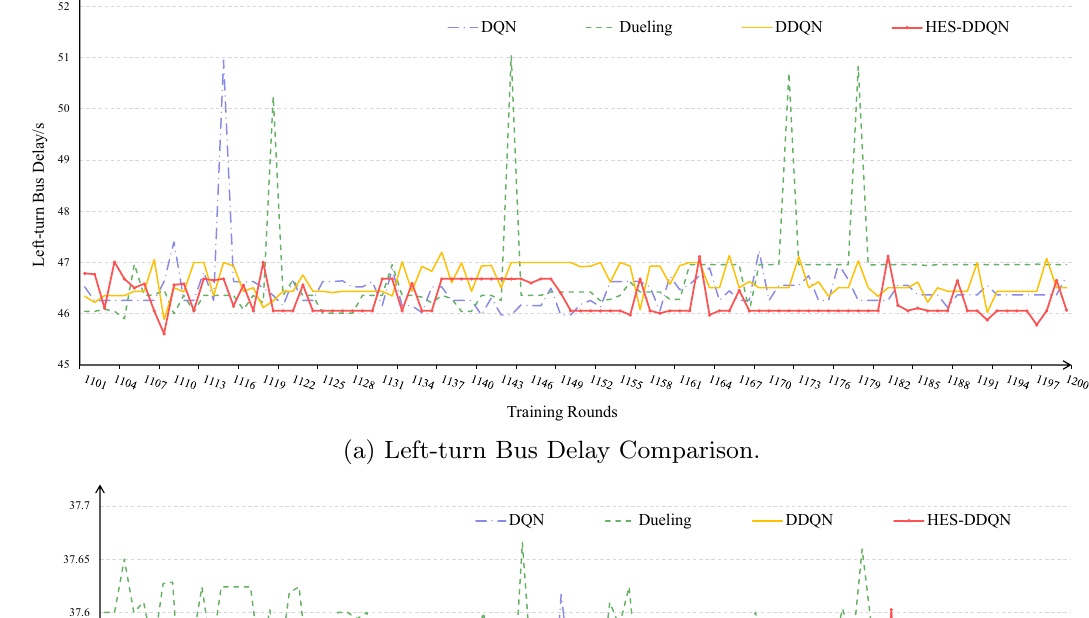
(a) Left-turn Bus Delay Comparison.